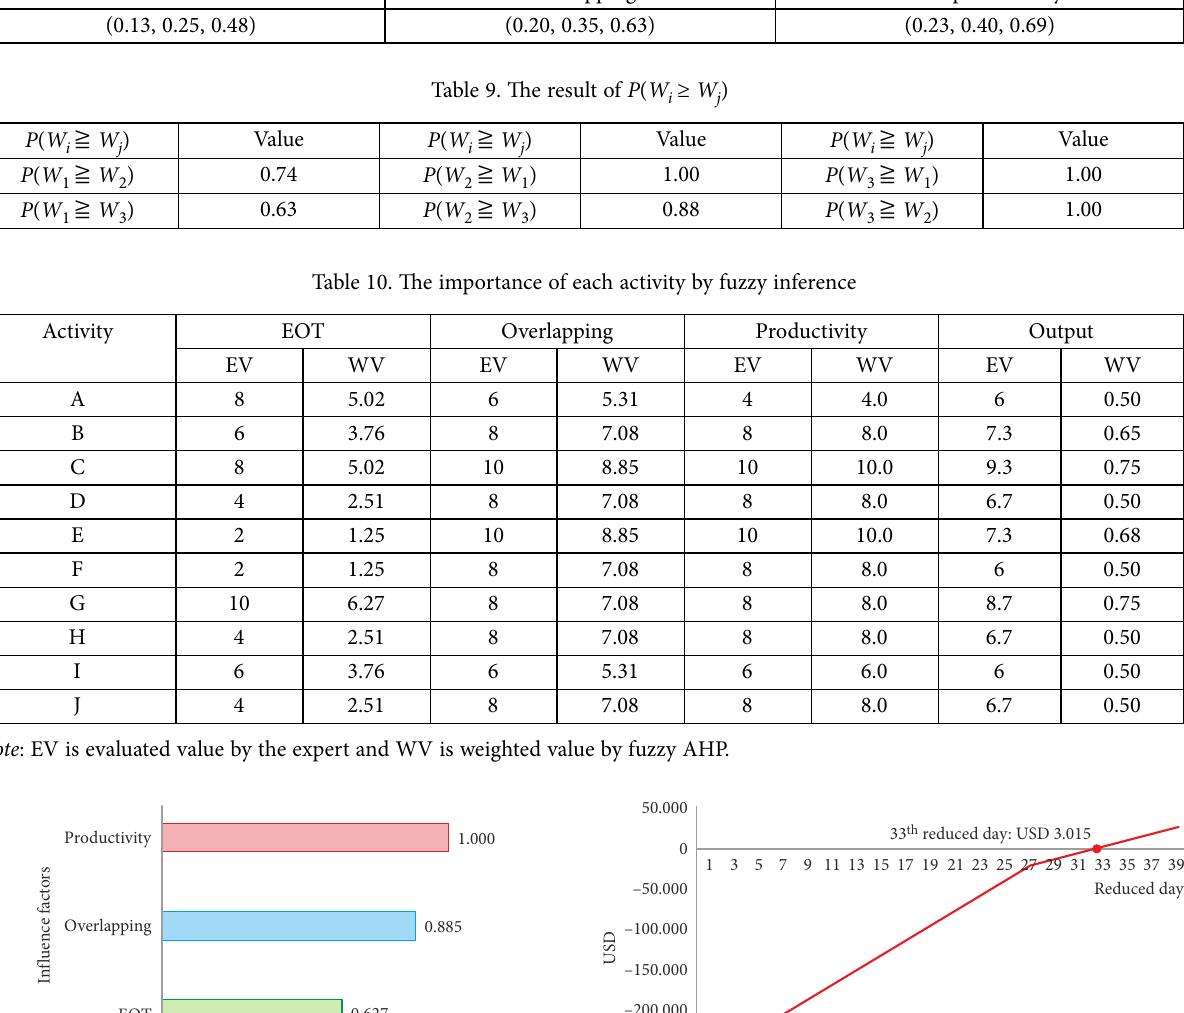
Table 8. The importance of the triangular fuzzy number for the selection factors Overlapping Work productivity